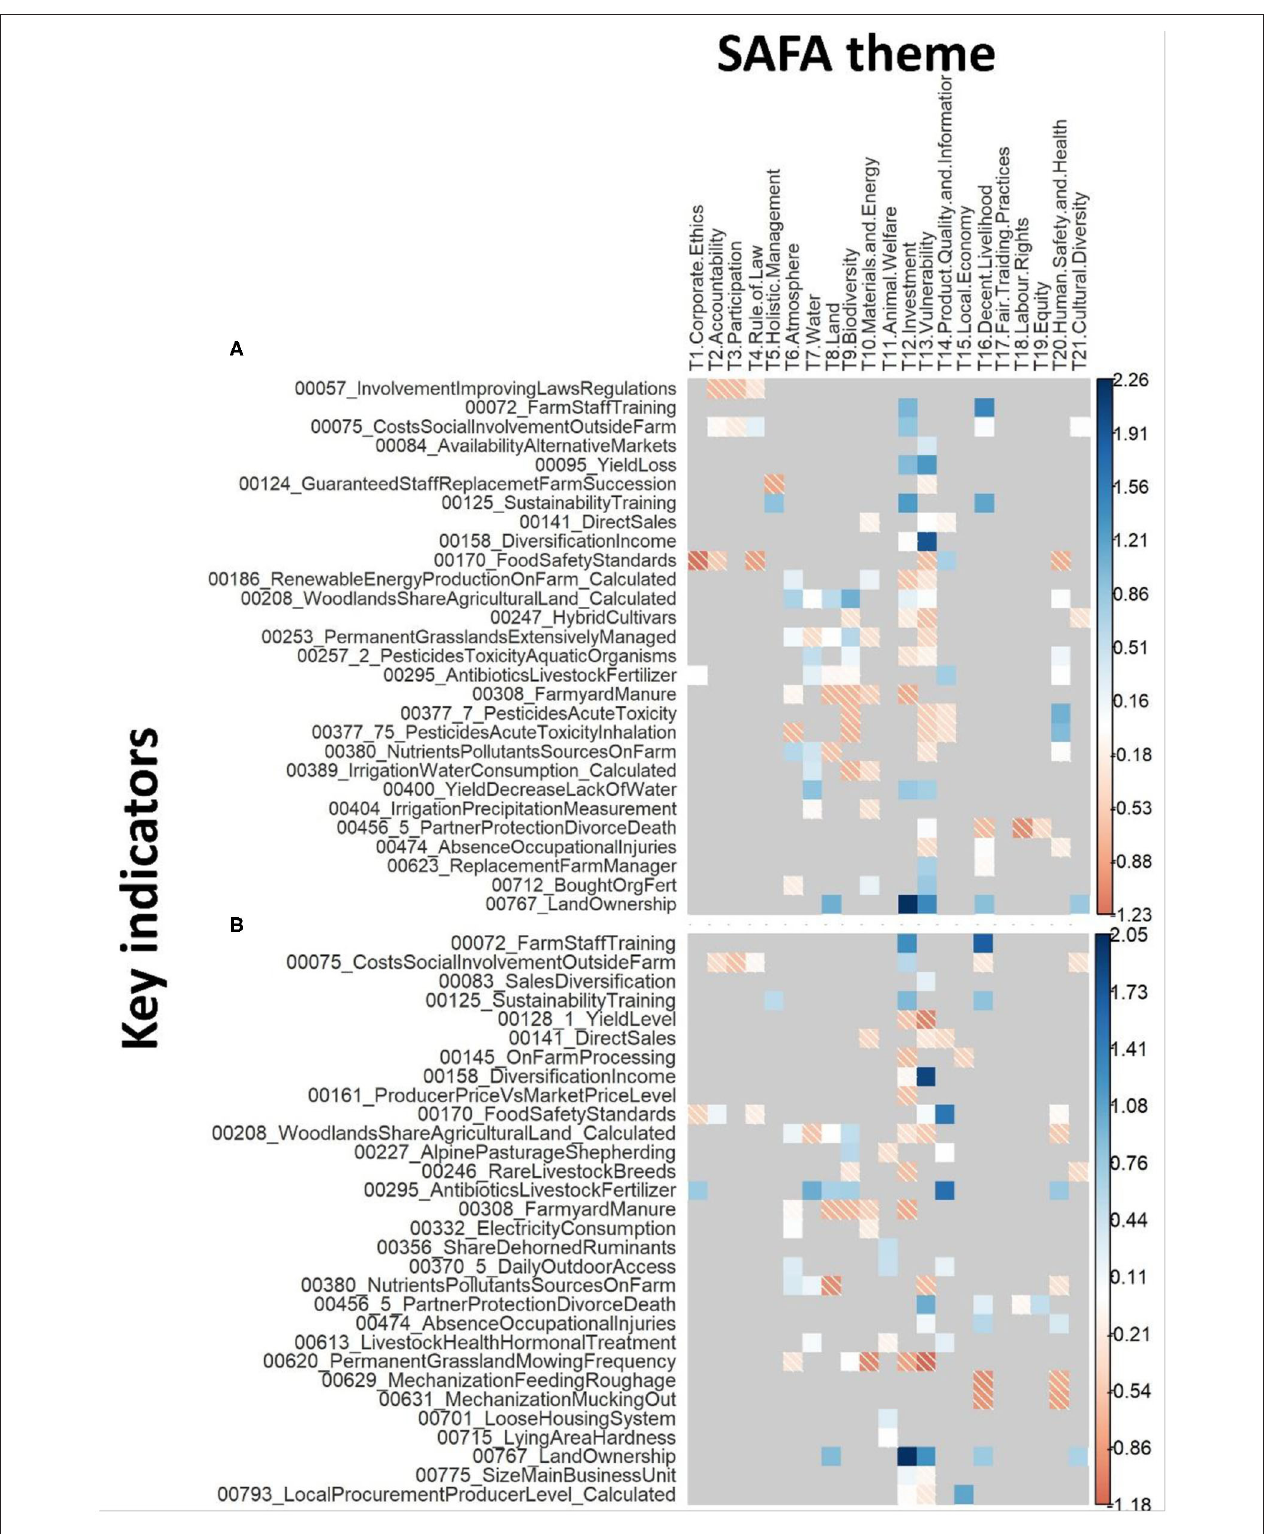
FIGURE 4 | Heat map of interactions between influential indicators and SAFA themes for plant production and mixed (PM) farms (A) and livestock (LS) farms (B) . Indicator-theme interactions are colored based on Z-normalized combined weights (dark blue = more important for goal achievement and explaining variance). Each indicator can interact with (impact on) multiple themes. Missing interactions (no value) in